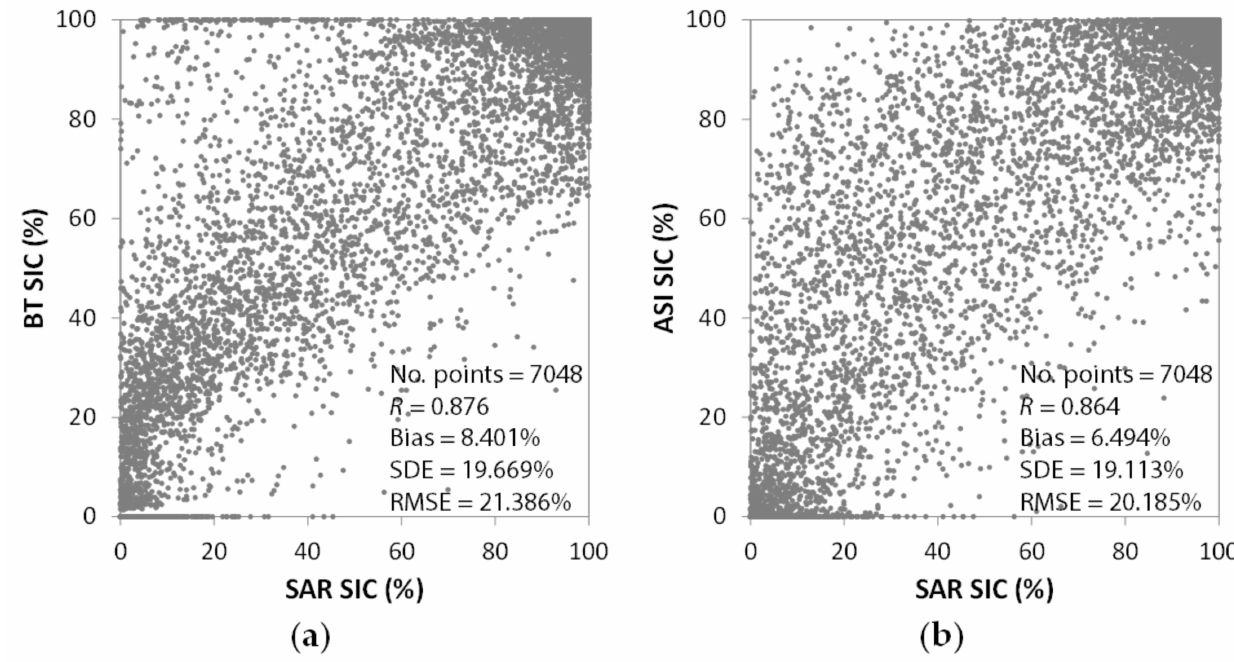
Figure 5. Comparisons of SIC values computed from the KOMPSAT-5 ice/water maps with those from the ( a ) BT and ( b ) ASI